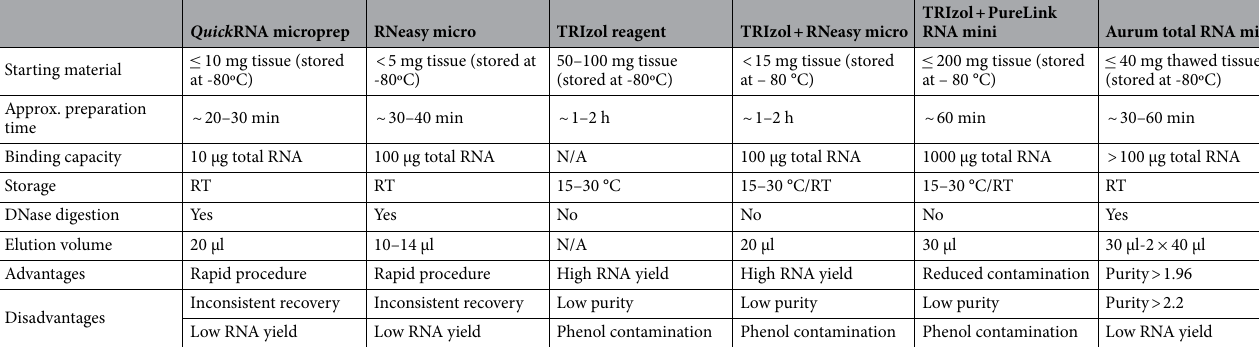
Electropherogram peaks showed general depreciation of RNA molecules and insufficient total RNA recovery using standard tissue handling procedures (Fig. 2b–d, left ). Alternatively, the addition of RNase- inhibiting reagents caused more distinct ribosomal RNA peaks and increased the RIN (Fig. 2b–d, right ). Low 28S/18S ratios (below 2.0) also revealed the vulnerability of RNA during isolation steps; however, the reliability of the 28S/18S ratios as an indication of relative degradation is unclear (Fig. 2b,d). Together, the low 28S/18S ratios and the small, rounded peaks at the baseline observed in the electrophoretic traces indicated that RNase- inhibiting reagent treatment provided partial stabilization (Fig. 2b–d, right ). Beyond its indispensable inhibitory properties, overnight incubation in RNase-inhibiting reagent also promoted the hardening of the muscle fibers, which increased the labor required to affect cell lysis.